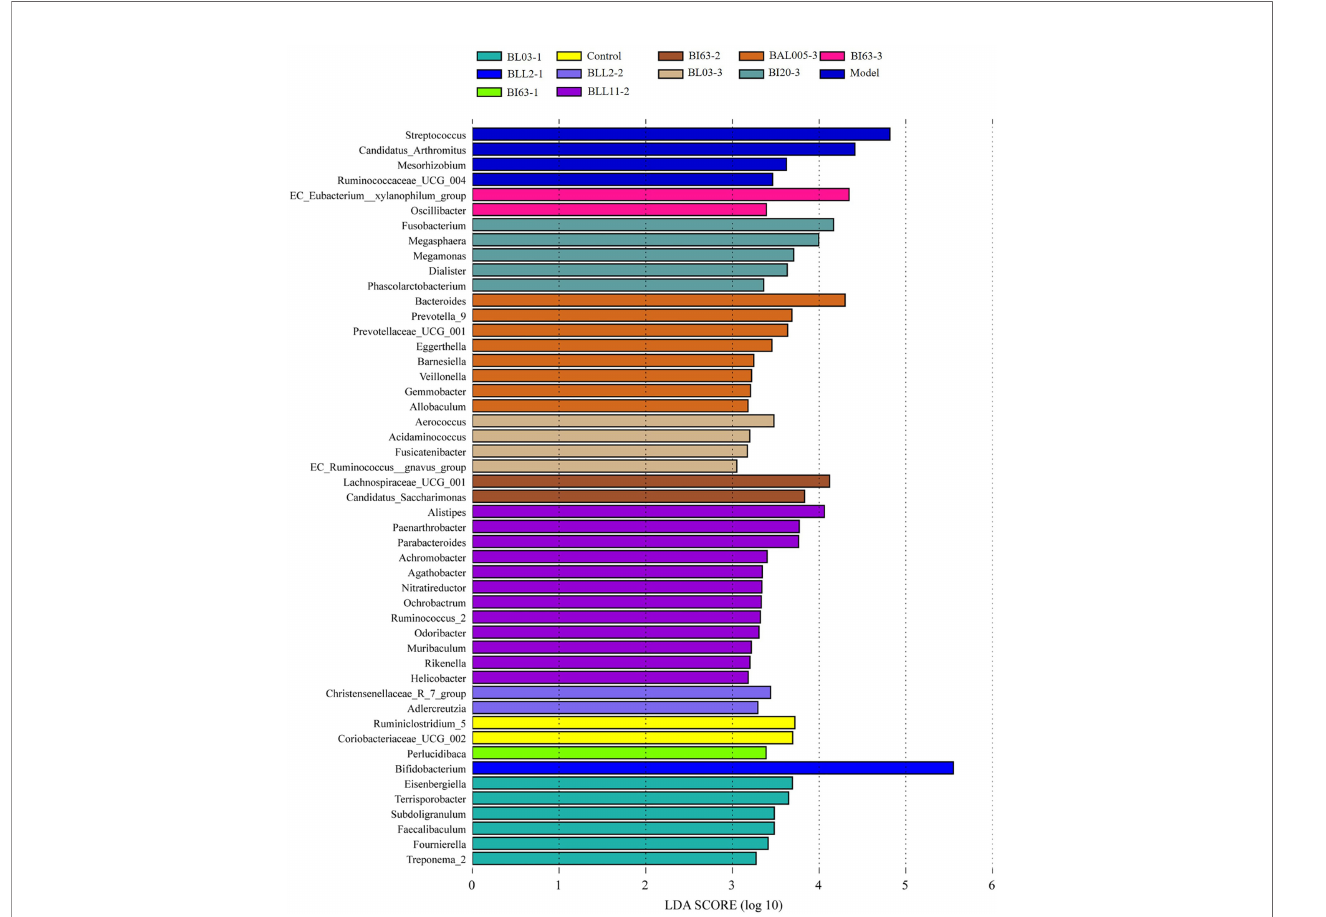
FIGURE 9 | The LEfSe analysis of gut microbiota in mice treated with different embedding methods.